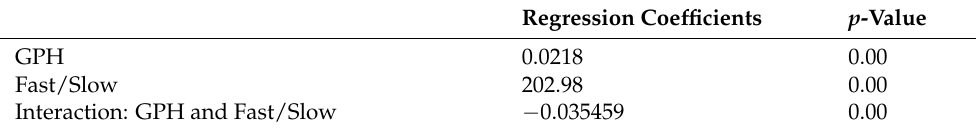
Table 2. Statistical modeling of the number of extreme translation events as a function of geopotential height (GPH) and fast/slow events (dummy variable). This model considers the interactions between GPH and fast/slow.